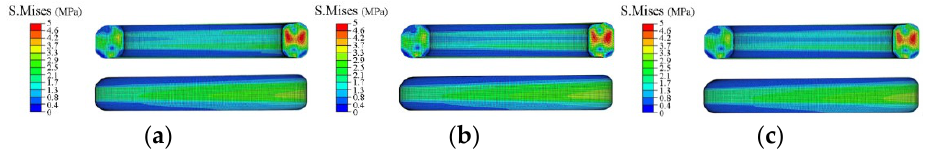
Figure 12. Stress distribution of O-ring under different working distances. ( a ) 0 km; ( b ) 7.2 km; ( c ) 28.8 km.